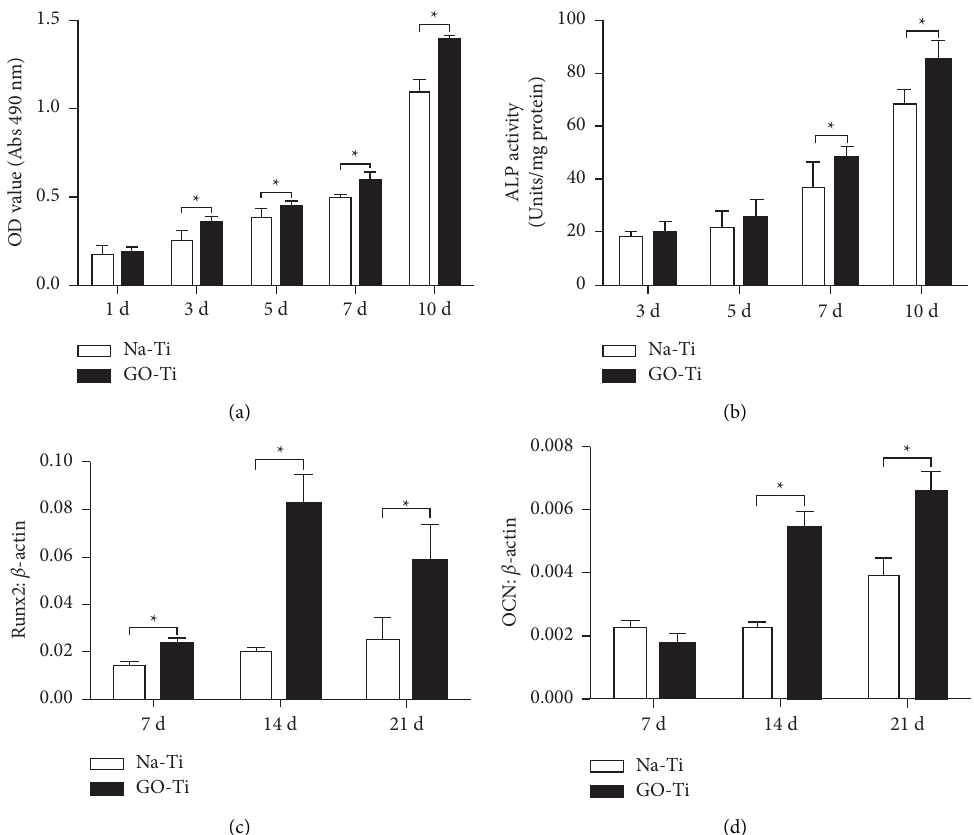
Figure 12: (a) MTTcell viability assay. (b) ALP activity. (c) Runx2 osteogenic gene expression in hPDLSCs seeded onto Go-Ti and Na-Ti substrates. (d) OCN osteogenic gene expression of hPDLSCs seeded onto Go-Ti and Na-Ti substrates (reprinted with permission from Zhou et al. [75] following the Creative Commons Attribution (CC BY) license (https://creativecommons.org/licenses/by/4.0/) (accessed on 4 May